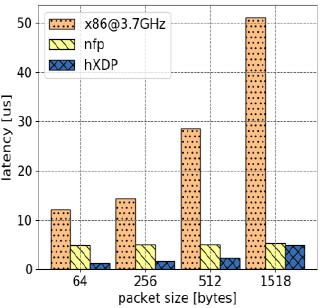
Figure 10. Performance evaluation latency measurements.